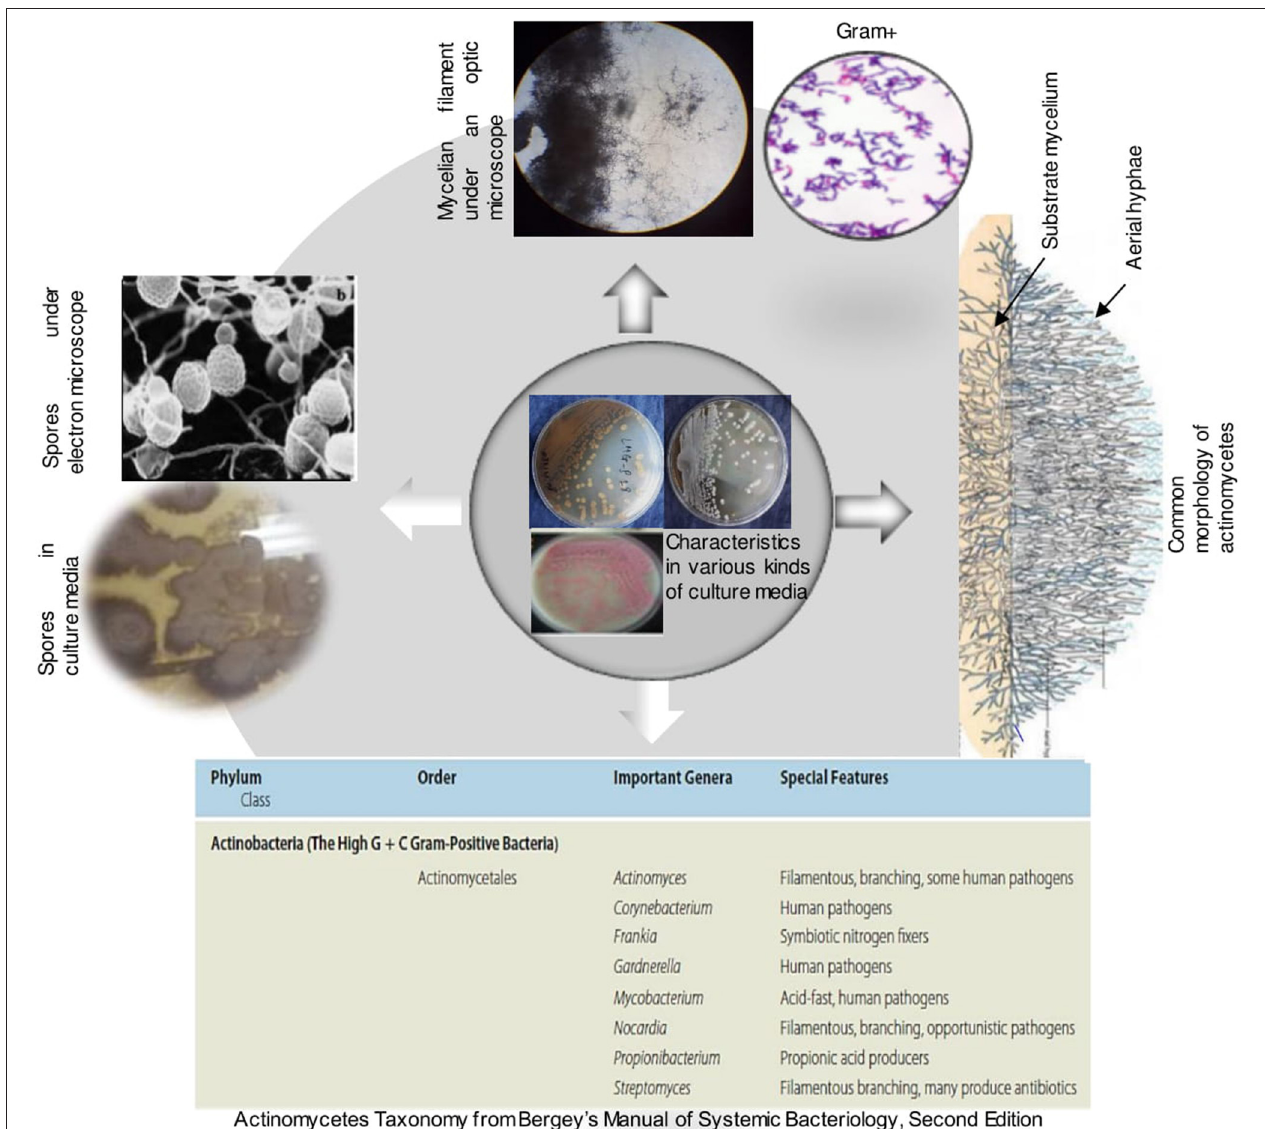
FIGURE 5 | Some features of actinobacteria (Bergey’s Manual of systematic Bacteriology, Barka et al.,